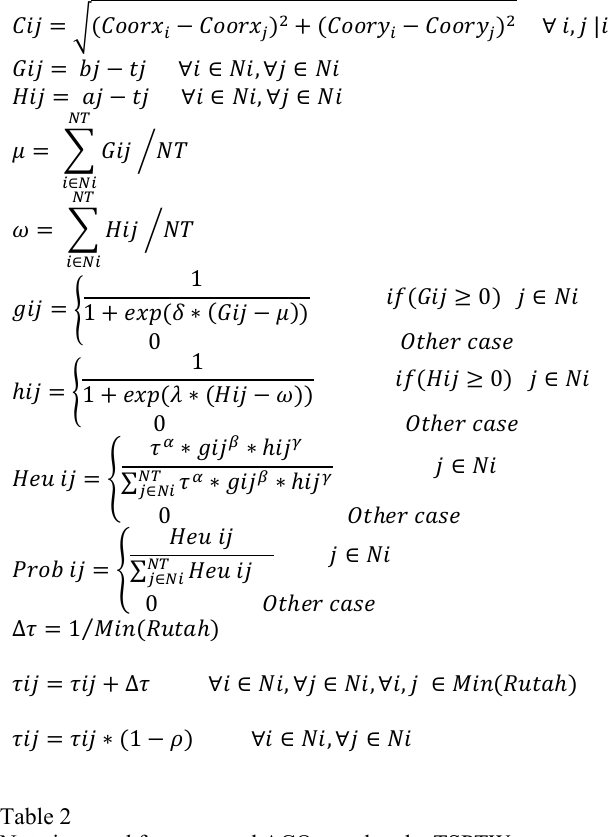
Notation used for proposed ACO to solve the